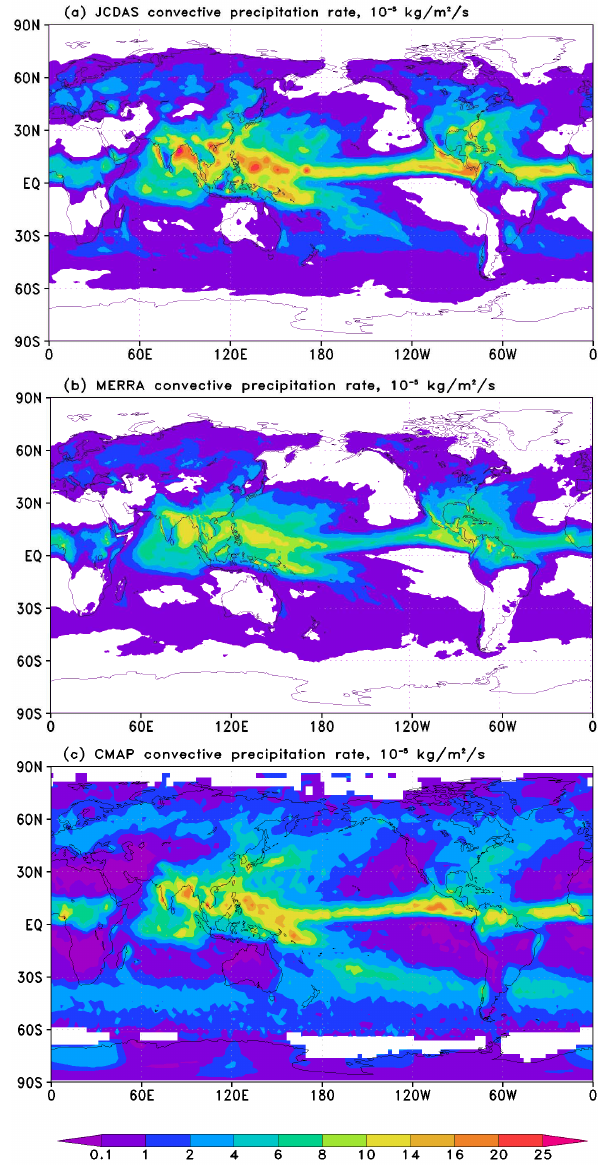
Fig. 2. Seasonal (JJA) mean convective precipitation rates from the (a) JRA-25/JCADS, (b) MERRA and (c) CMAP total precipitation rates (10 − 5 kg m − 2 s − 1 ) for